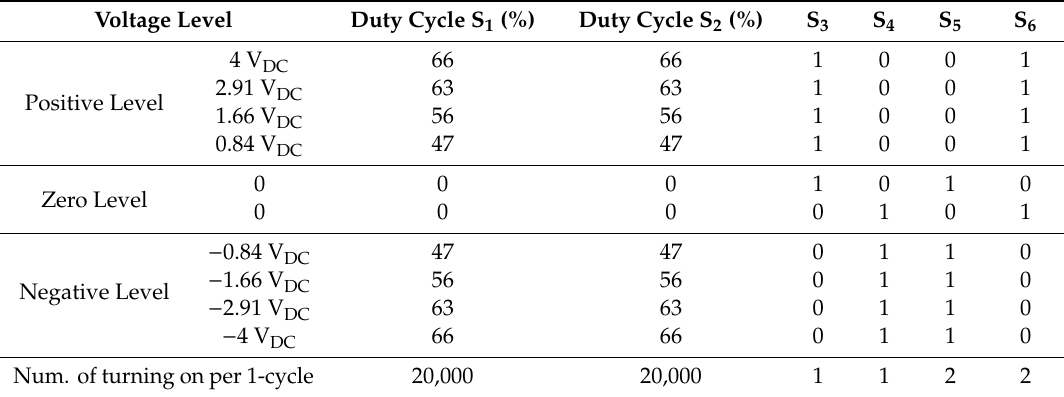
Table 5. Switching table level = 9, gain =